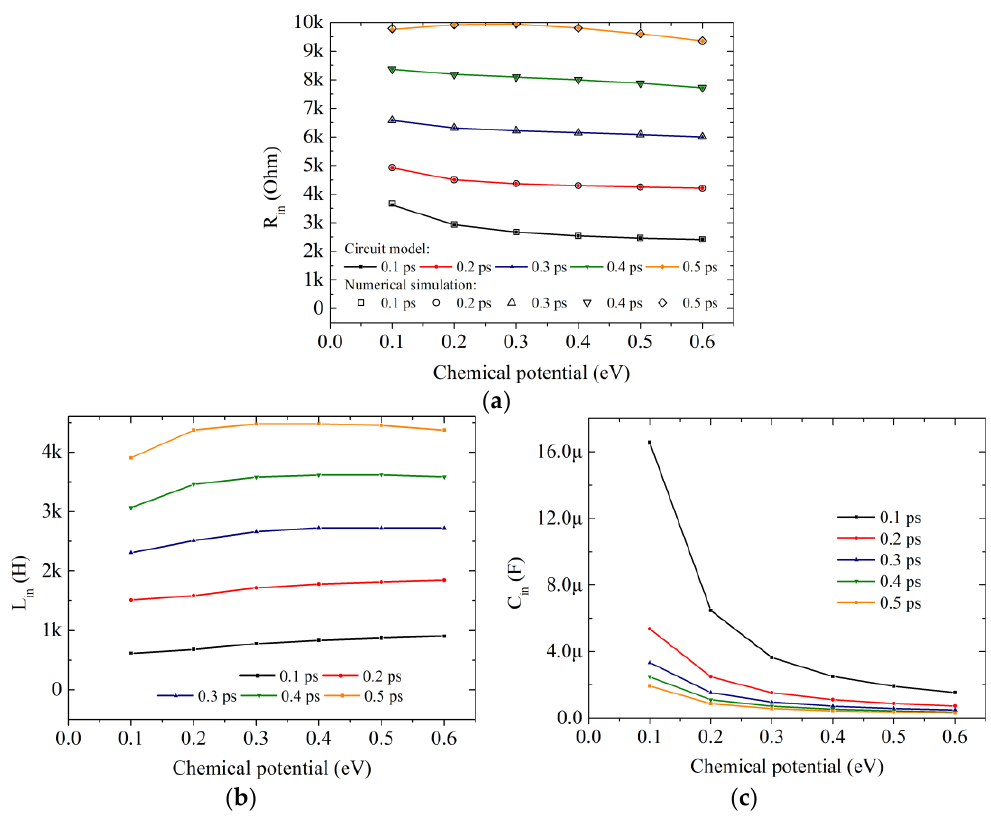
Figure 8. Equivalent circuit parameters. ( a ) R in , ( b ) L in , and ( c ) C in of the equivalent circuit against chemical potential with different relaxation times: 0.1 ps, 0.2 ps, 0.3 ps, 0.4 ps, and 0.5 ps.